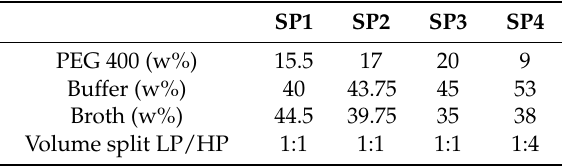
Table 6. Composition of the investigated